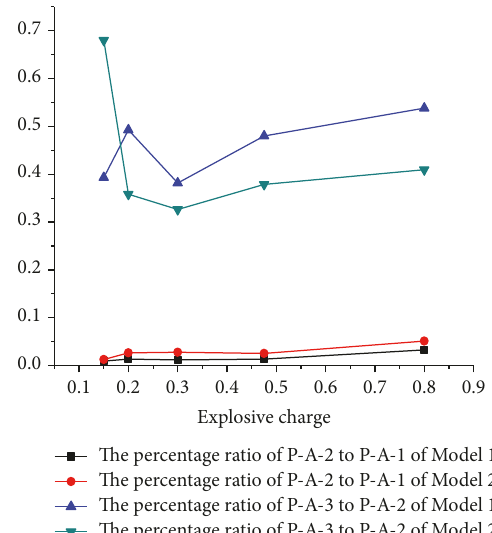
Figure 20: Percentage ratio of pressure at each measurement point.